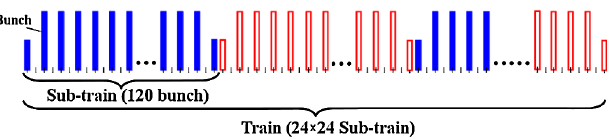
FIG. 1. The charge distributions along the pulse different sub- trains are shown in